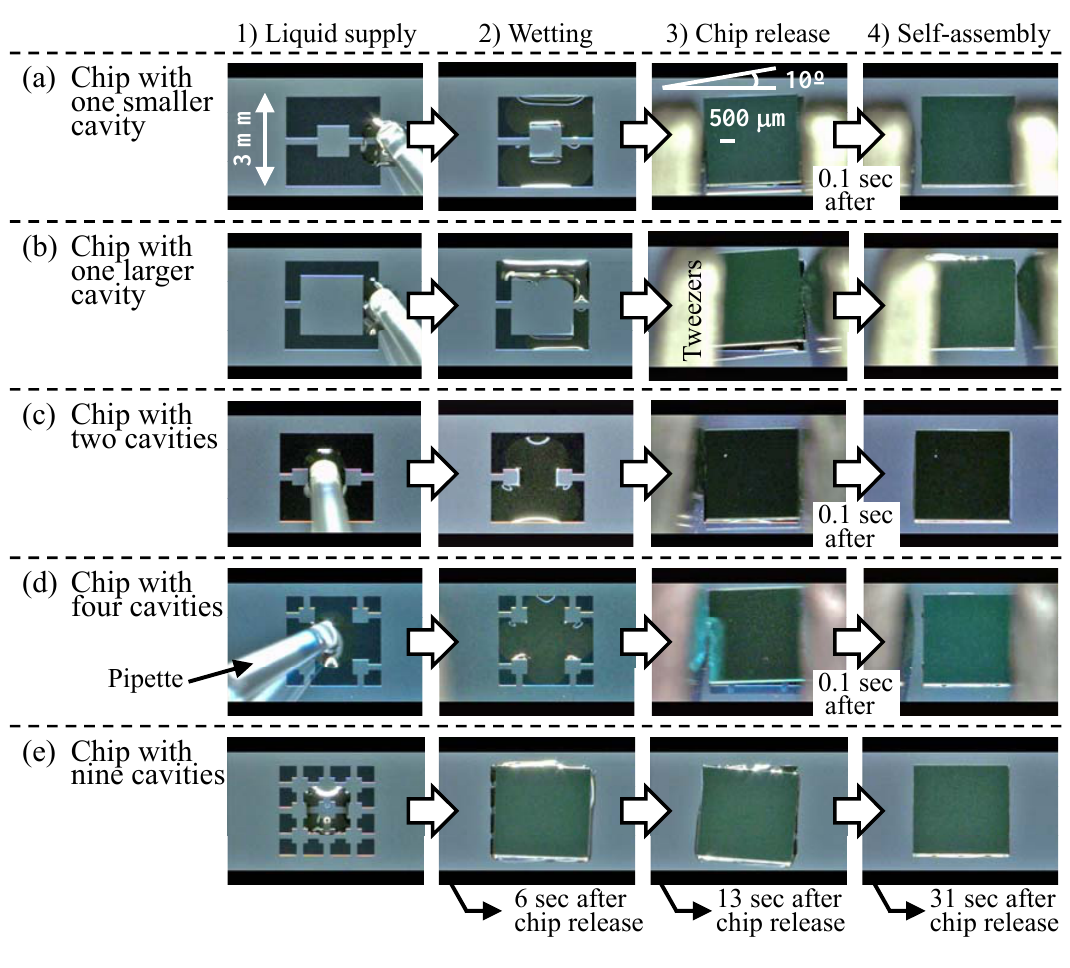
Figure 6. Video frames from shorts movies of self-assembly with chips having a